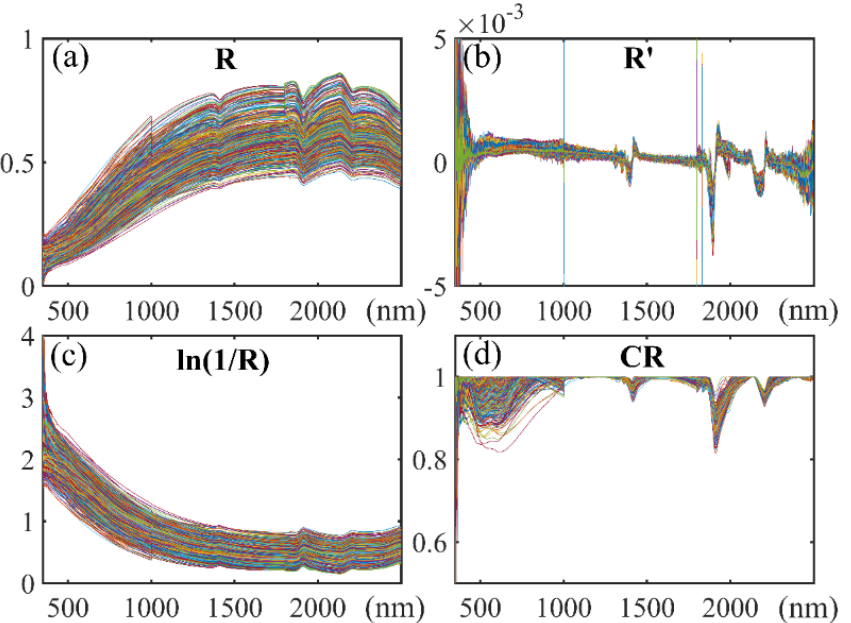
Figure 4. ( a ) Original spectral reflectance; ( b ) The first derivative of the reflectance; ( c ) The logarithm of the reciprocal to the reflectance; ( d ) The result of the continuum removal to the reflectance.